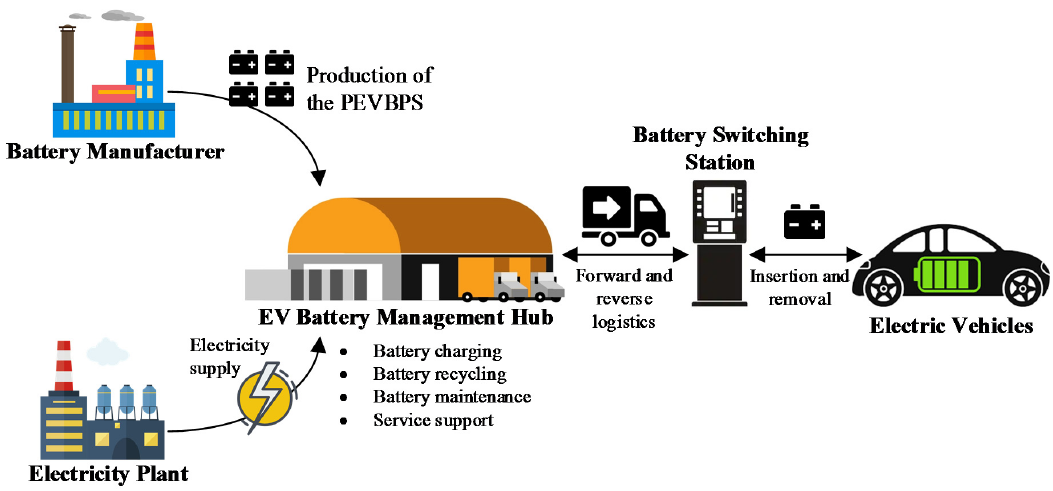
Figure 1. Graphical illustration of the plug-in electric vehicle battery pack standardization (PEVBPS)-based electric vehicle (EV) industry.